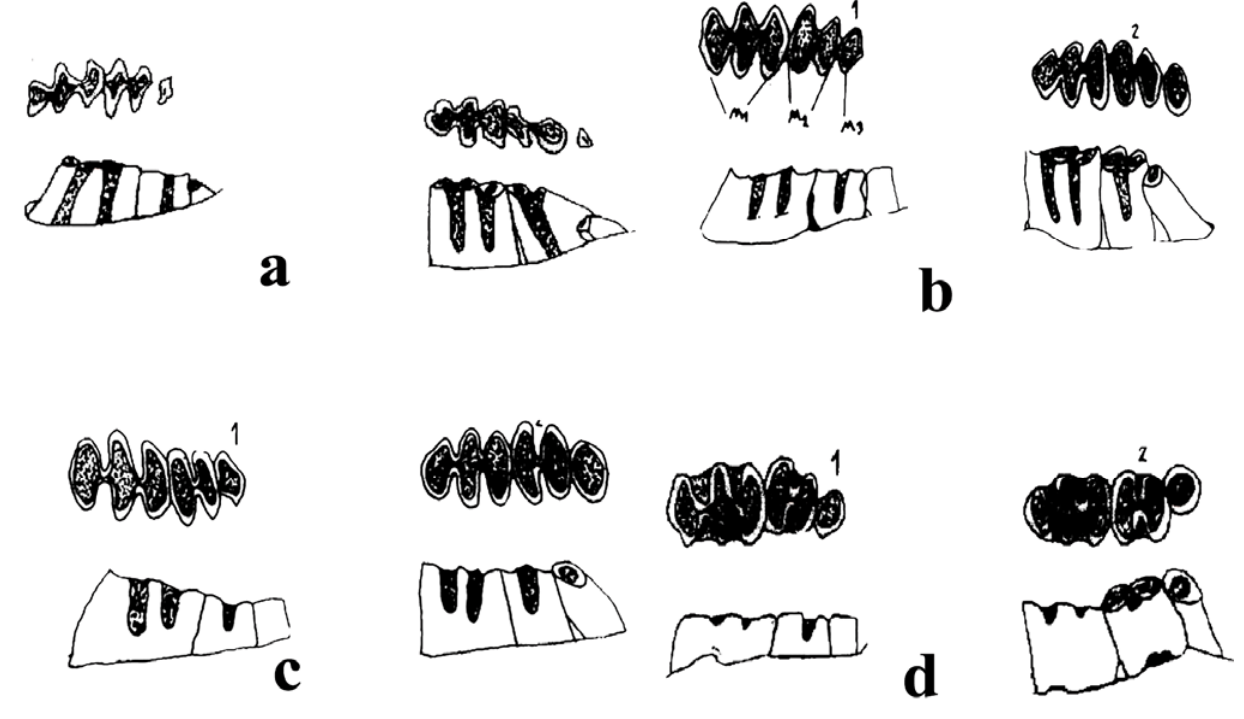
F IG . 5.- Age class determination of the studied Jirds on the basis of wearing quantity of molar teeth in four groups of a) new born, b) juvenile, c) adult, and d) old